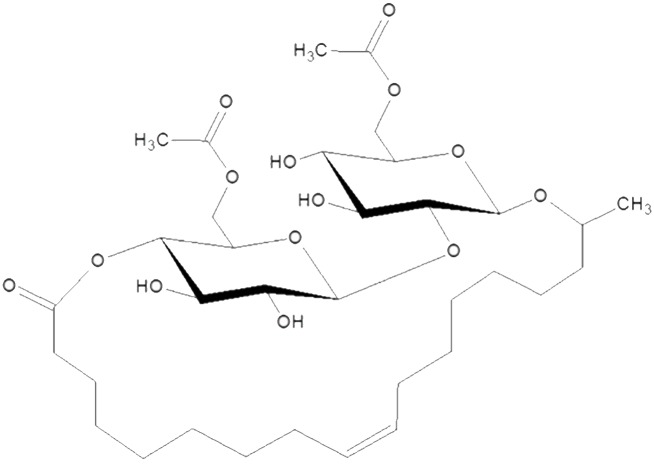
Lactonic Sophorolipid.The structure of C18:1 diacetylated LSL.